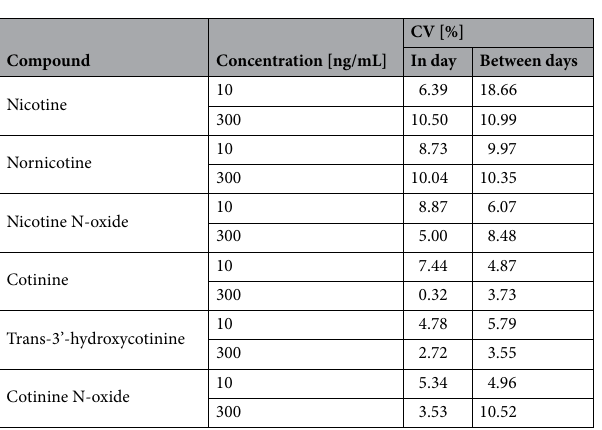
Table 2. Repeatability of the plasma nicotine and their metabolites determination of the day and between days.